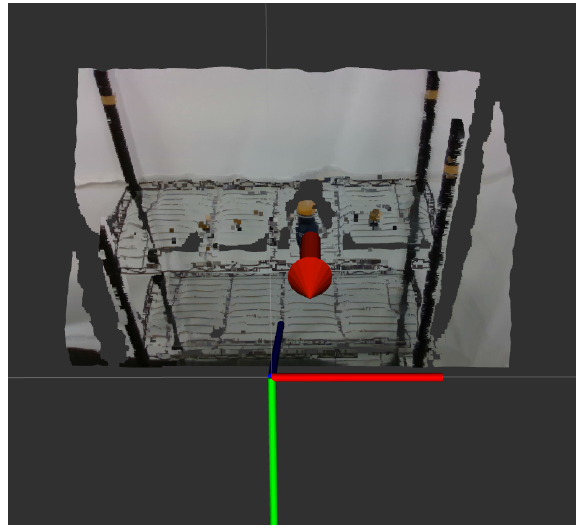
Figure 11. Schematic diagram of unit vector calculation results for PET bottle.